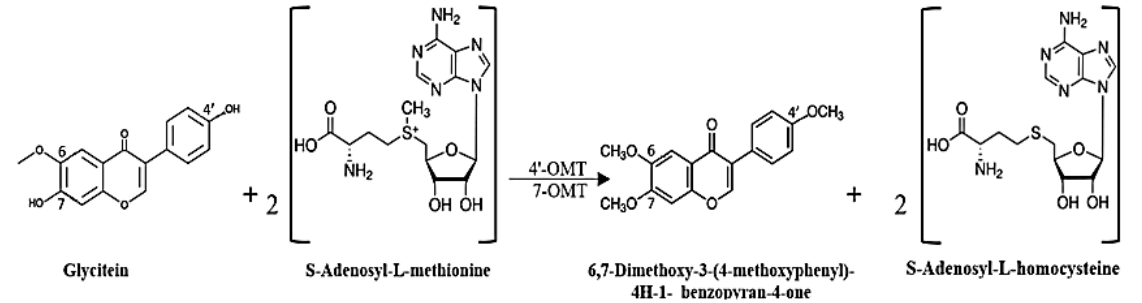
Figure 5. Possible biosynthetic pathway of 6,7-Dimethoxy-3-(4-methoxyphenyl)-4H-1benzopyran- 4-one ( 50 ).